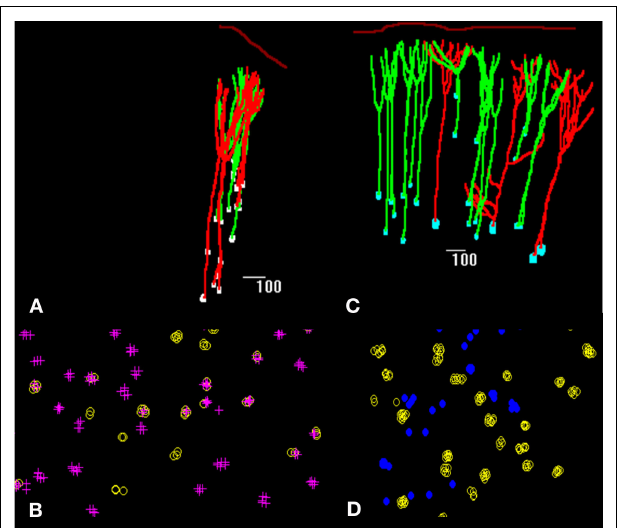
FIGURE 2 | Spatial distribution of retrogradely labeled pyramidal neurons in the rat visual cortex (A,C) and tangential maps of apical dendrites (B,D) drawn with Neurolucida software. In (A) , neurons projecting to the corpus callosum in red and neurons projecting to the ipsilateral cortex in green; in (B) apical dendrites of callosally projecting neurons are identifi ed by crosses, those of ipsilaterally projecting corticocortical neurons by yellow circles. In (C) , neurons projecting to the corpus callosum in green and neurons projecting to the superior colliculus in red; in (D) apical dendrites of callosally projecting neurons are identifi ed by yellow circles, those of corticocollicular neurons are identifi ed by blue dots.